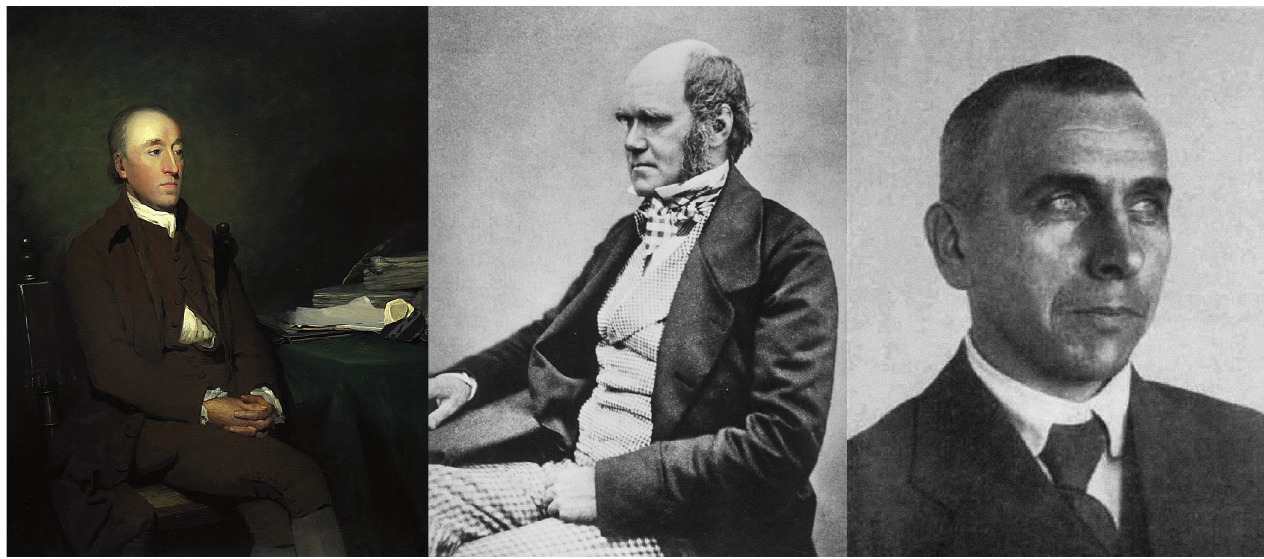
Figure 1. Left to right: James Hutton (1726-1797), Charles Darwin (1809-1882), and Alfred Wegener (1880-1930) (from